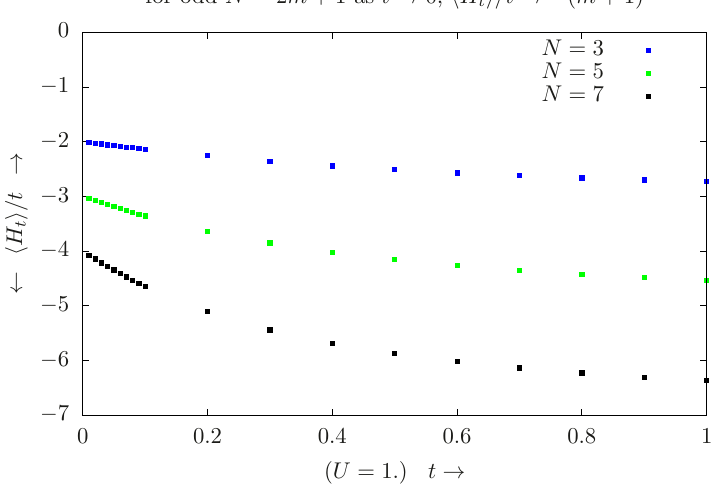
Figure 9 . Hopping VEV for odd N = 2 m + 1